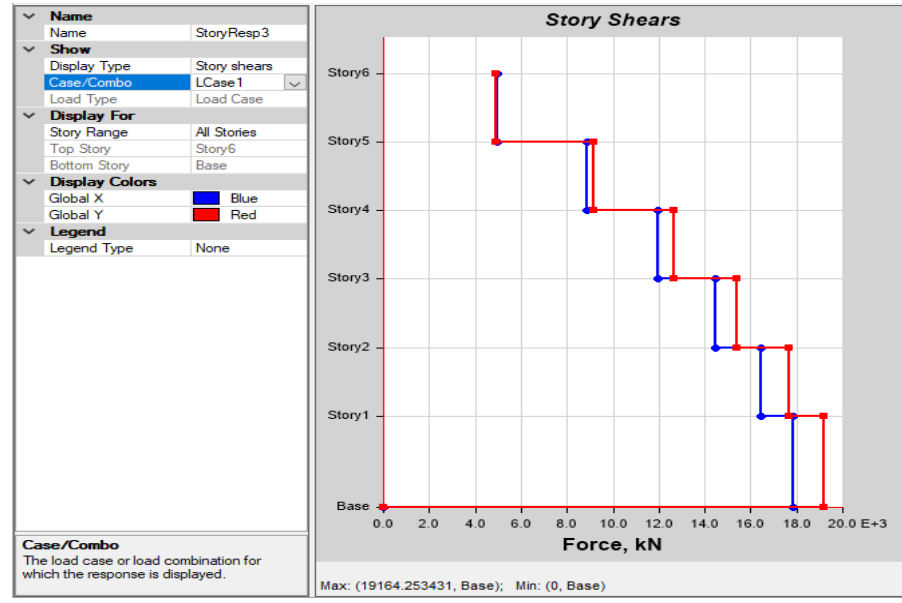
Figure 7. Maximum story drift.